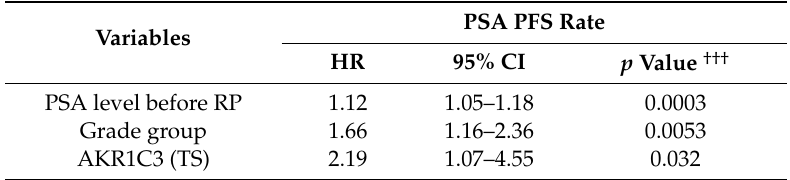
Figure 3. Kaplan–Meier survival curves revealed that the AKR1C3 positive group (TS ≥ 3) had a significantly lower PSA PFS rate than the negative group (TS ≤ 2) ( p = 0.042, log-rank test). Table 3. Cox proportional hazard regression analysis of prostate-specific antigen progression free survival (PSA PFS) and clinical and pathological variables.